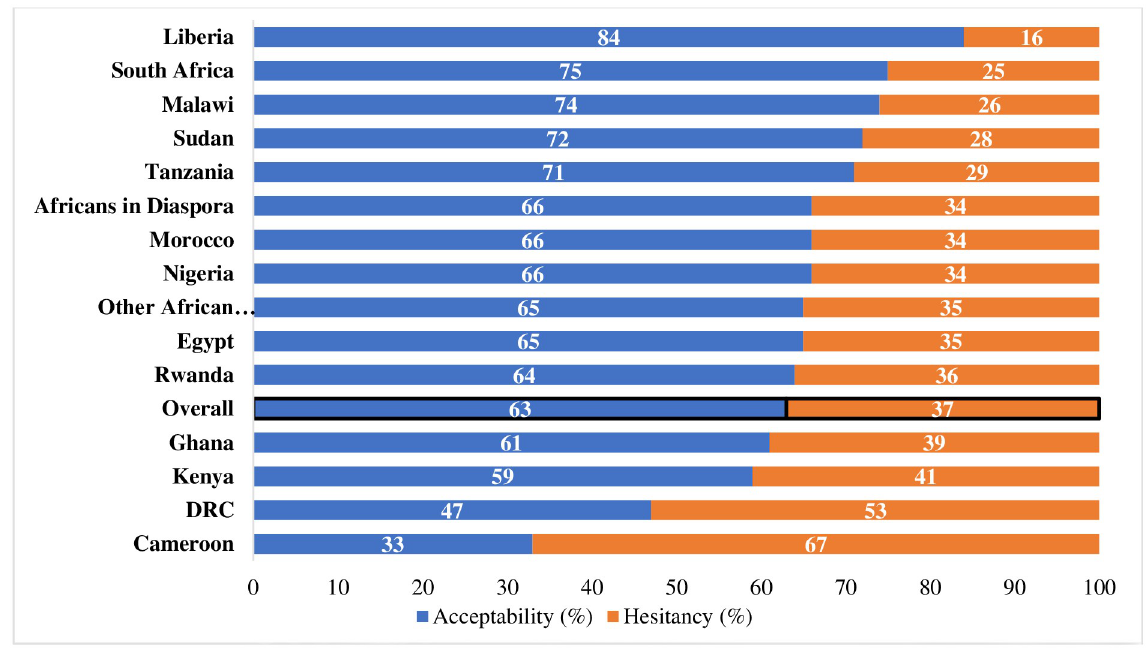
Fig 1. Percentage distribution of COVID-19 vaccine acceptability and hesitancy in Africa. A total of 5211 count data was used for this analysis. Specific number of data count per country are available in the S1 Table.